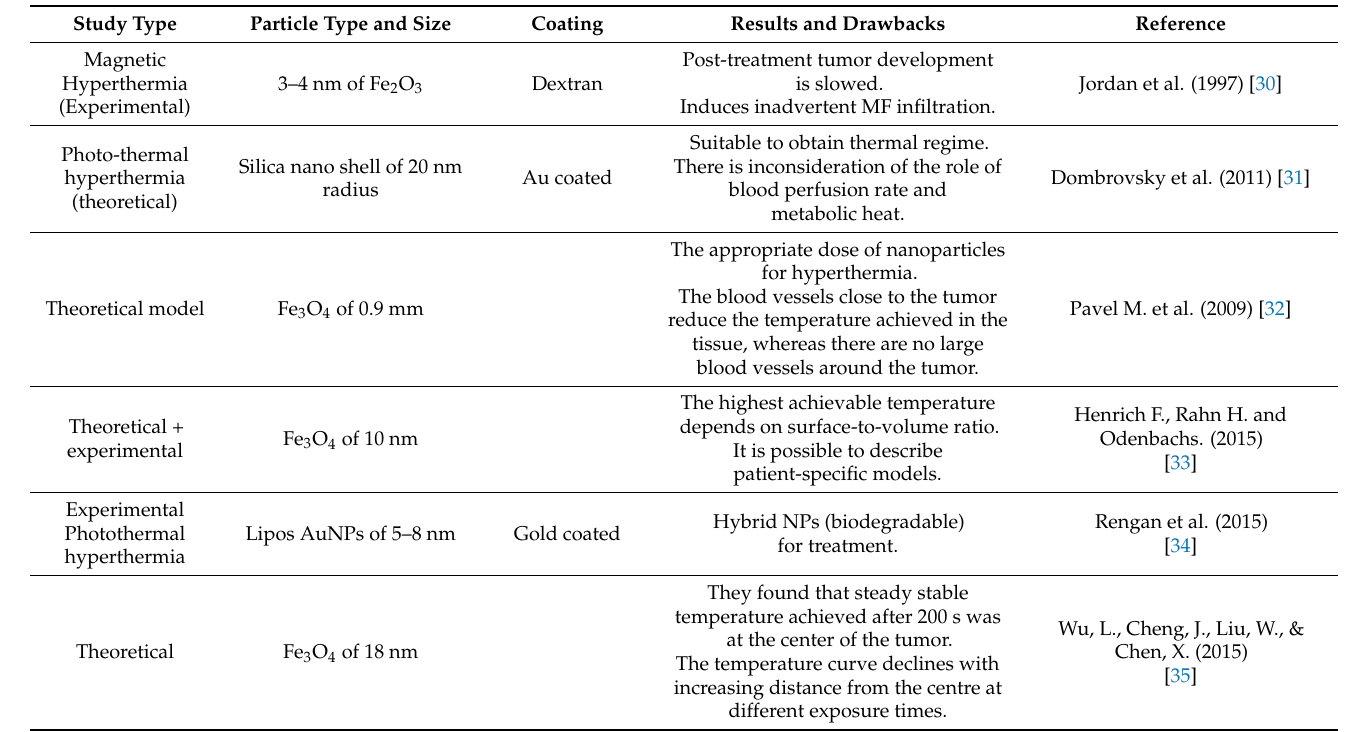
Table 1. A comparison of the past studies utilizing nanostructured materials for the treatment of